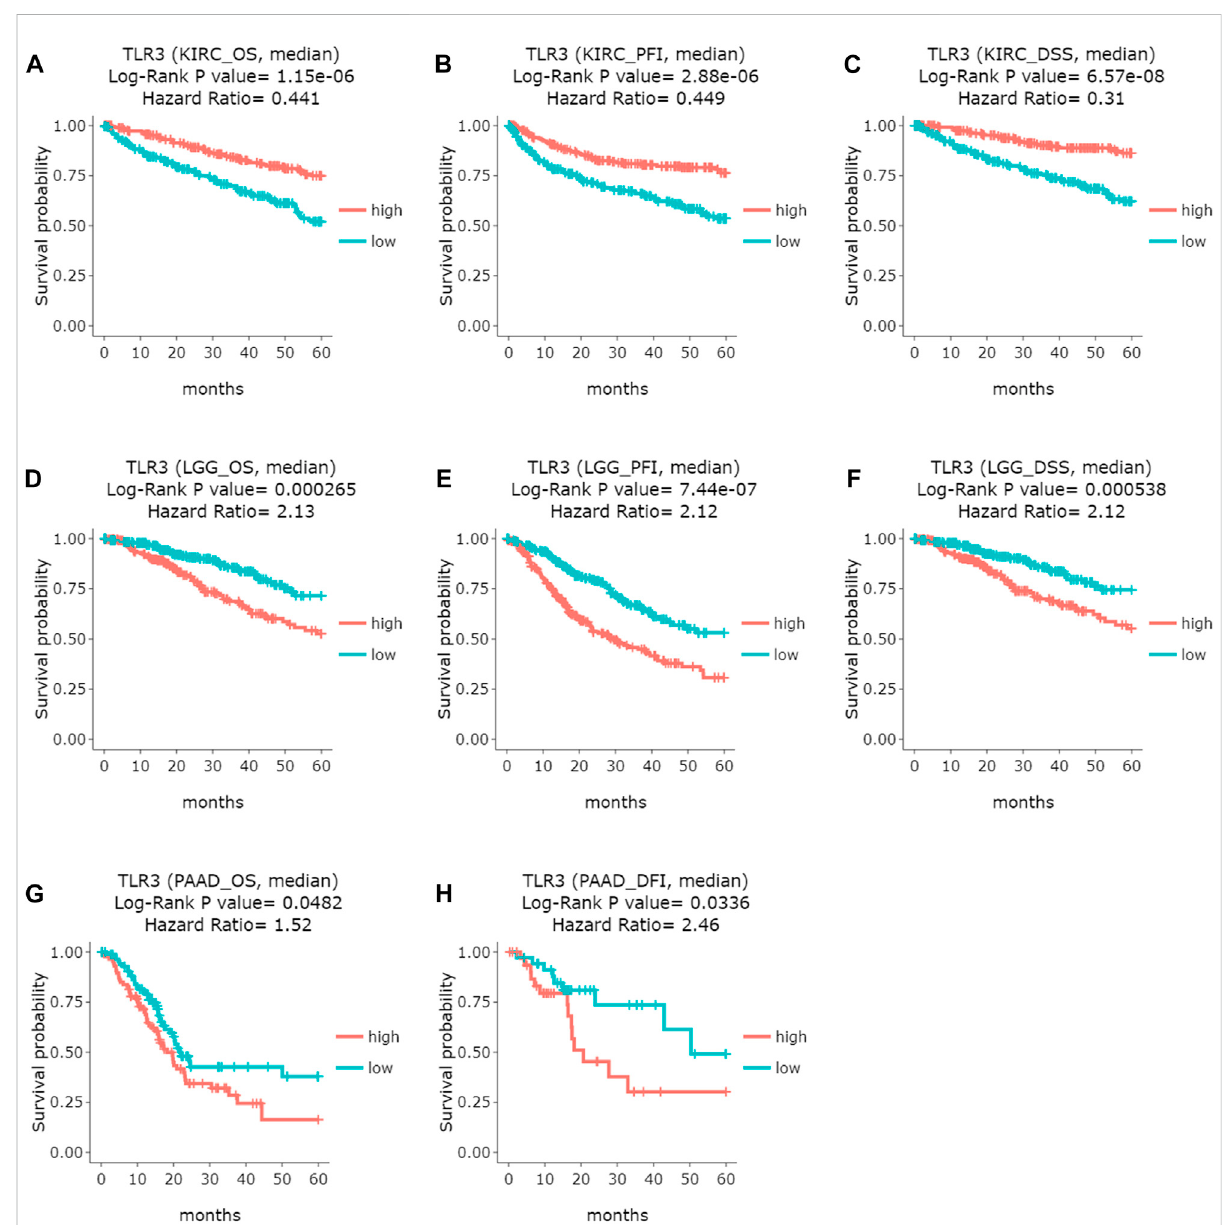
FIGURE 3 Comparing the effects ofhighand low expression ofTLR3 on KIRC, LGG and PAAD survival outcomesby DriverDBv3. (A – C) The effects of high and low expression of TLR3 on OS, PFI and DFS of KIRC. (D – F) The effects of high and low expression of TLR3 on OS, PFI and DSS of LGG. (G,H) The effects of high and low expression of TLR3 on OS and DFI of